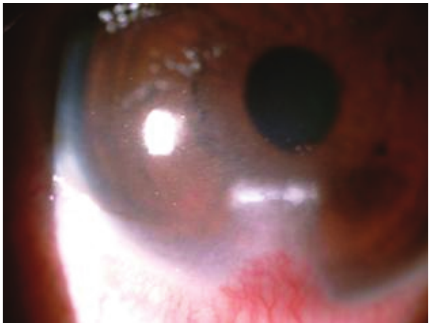
Figure 1: Corneal ulcer-paracentral, whitish dry looking ulcer. Figure 2: Healed corneal ulcer after